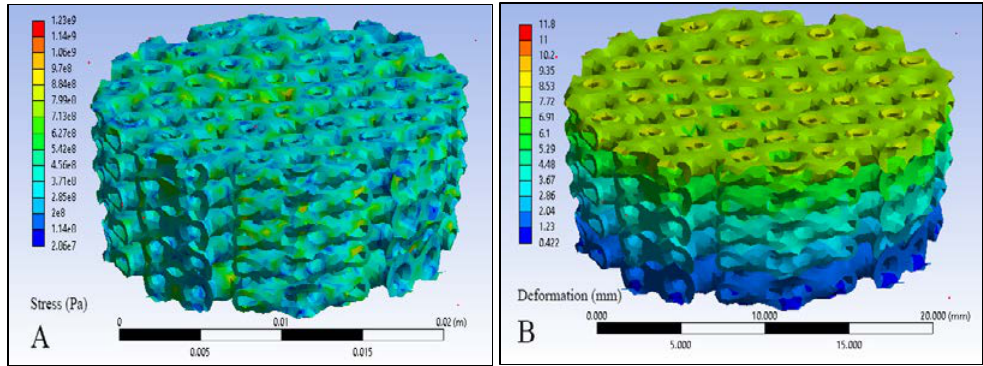
Figure 4. Primitive scaffold simulation: ( A ) Stress and ( B ) displacement (final height after compression 15 − 6.91 = 8.09 mm; the red dots are separated particles in contact with compressive punches).